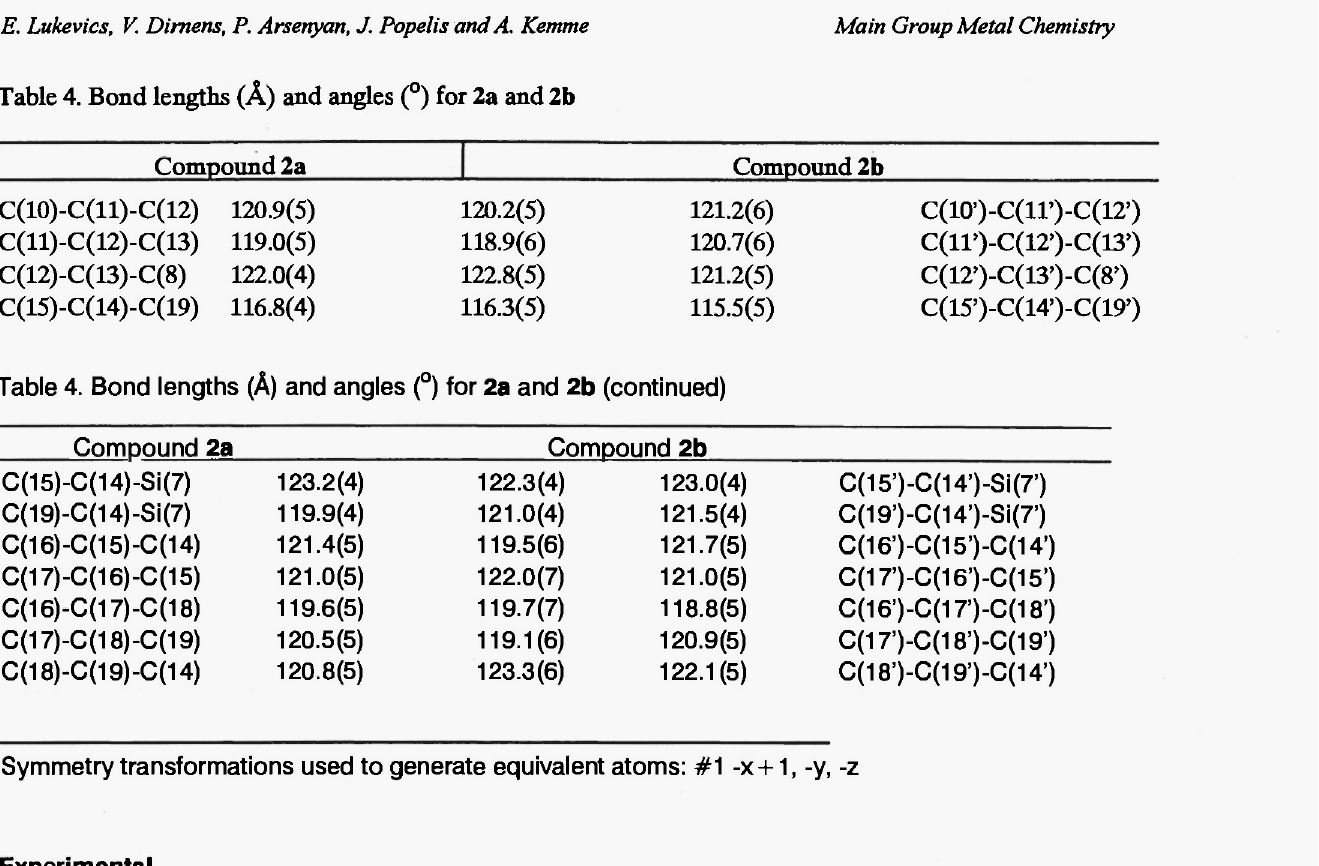
Table 4. Bond lengths (Ä) and angles (°) for 2a and 2b